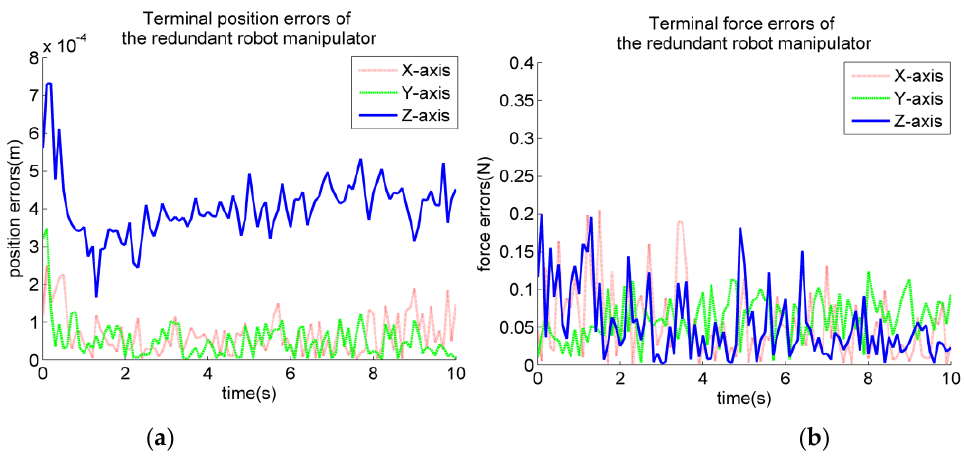
Figure 9. Control accuracy of the proposed algorithm ( a ) position control; ( b ) force control. Table 5. Position and force accuracies during the transport operation.